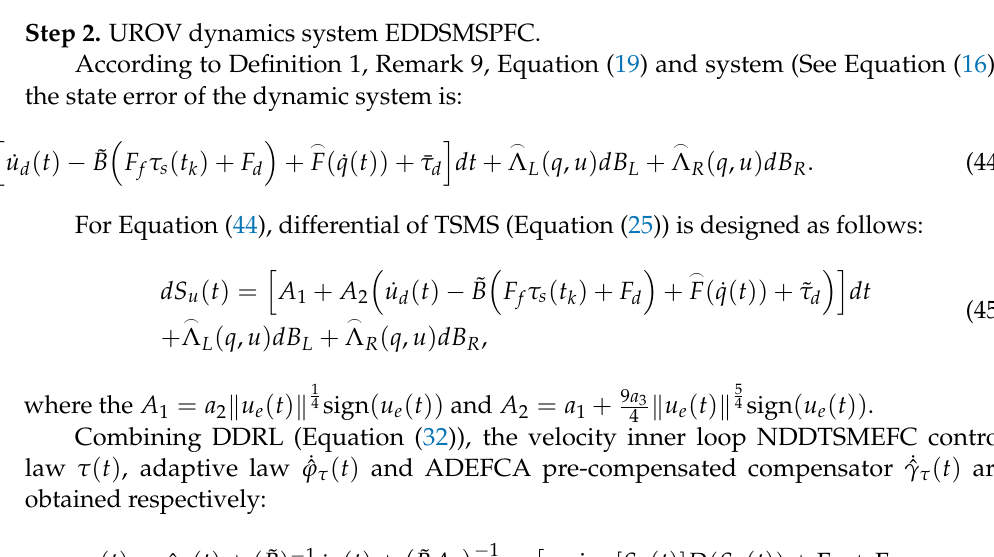
Figure 5. Schematic diagram of UTROV control